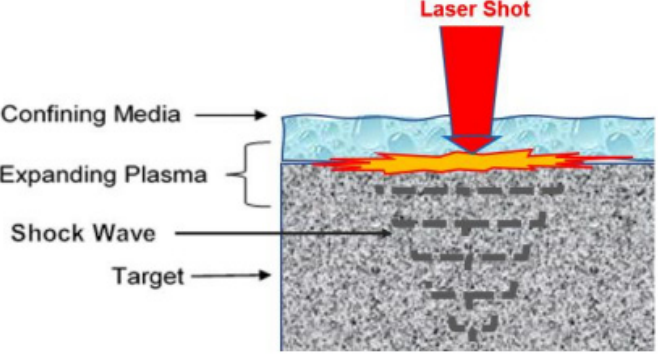
Figure 1. The confined laser shock peening process.